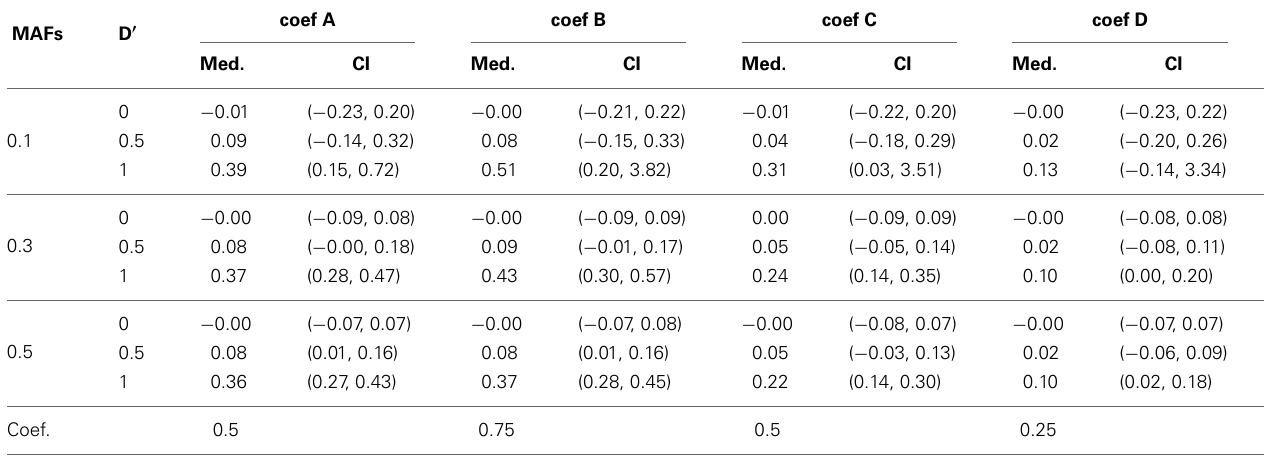
Table 4 | The median and 95% confidence interval of the interaction coefficient estimates at D (cid:2) = 0 , 0 . 5, and 1 when the two MAFs are the same.